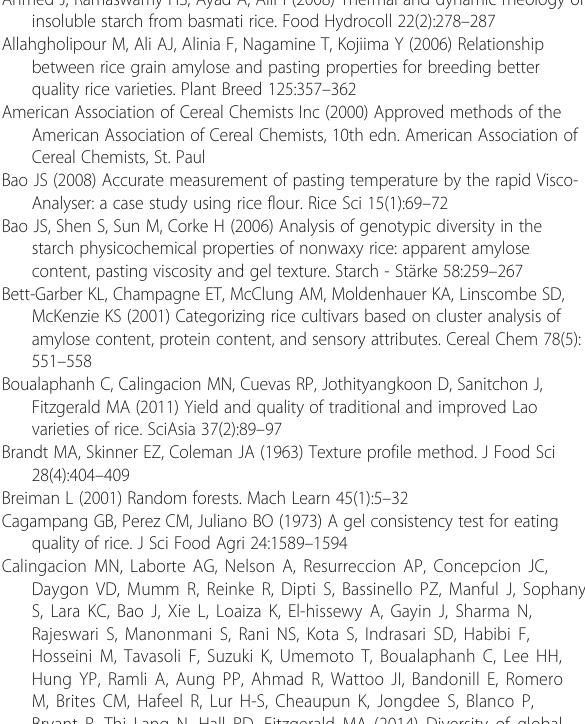
Table S3. Sensory evaluation scores 1 for the fifteen rice accessions from the three clusters. (DOCX 30 kb)